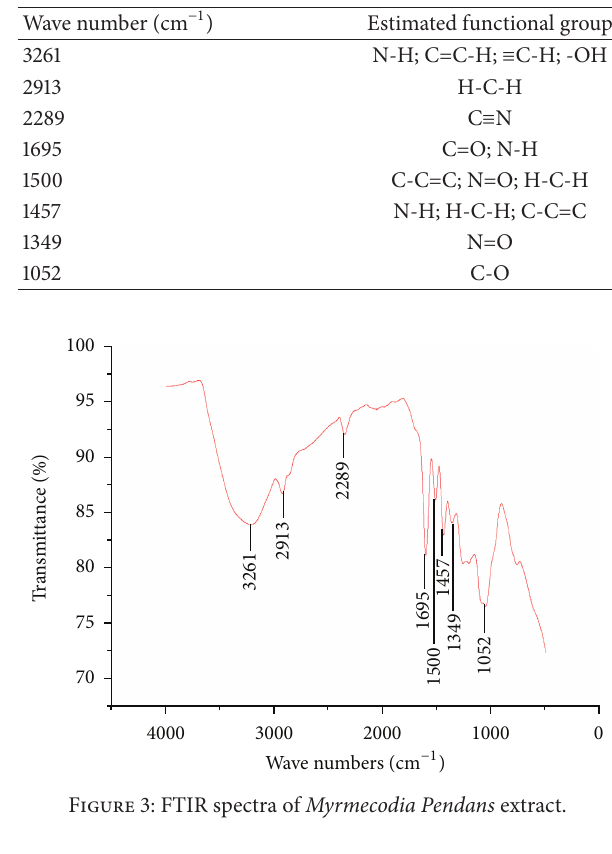
Table 3: Estimated functional group on Myrmecodia Pendans extract.